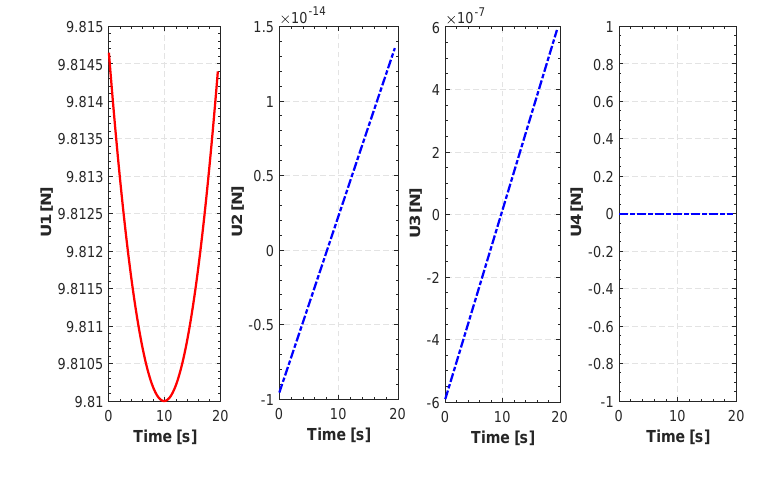
Figure 9. Control efforts for